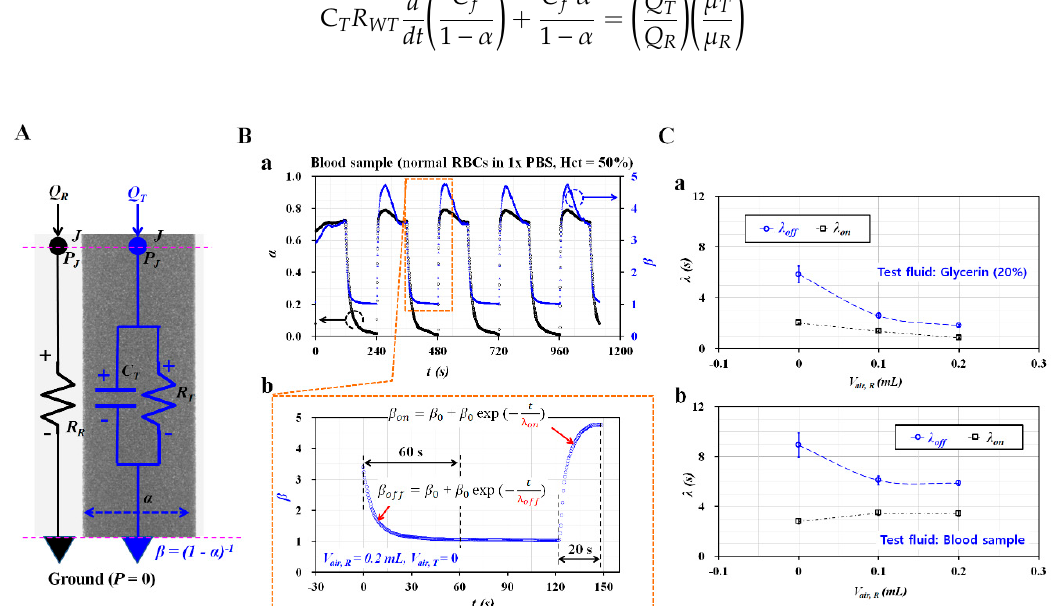
Figure 2. Quantitative evaluations of time constant with respect to the air cavity in the reference fluid syringe ( V air, R = 0, 0.1, and 0.2 mL). Here, the air cavity in the test fluid syringe was set to zero. ( A ) Fluidic circuit model for two fluids (reference fluid, test fluid) flowing in a co-flowing channel. ( B ) Quantifications of time constants ( λ o ff , λ on ) during each period. (a) Temporal variations of α and β with respect to V air, R = 0.2 mL. (b) Quantifications of λ o ff and λ on during turn-on and turn-o ff operation of the syringe pump. ( C ) Variations of λ o ff and λ on with respect to the test fluids (blood sample and glycerin (20%)) and air cavity in the reference syringe ( V air, R = 0, 0.1 and 0.2 mL). (a) Variations of λ o ff and λ on with respect to V air, R and glycerin (20%). (b) Variations of λ o ff and λ on with respect to V air, R and blood